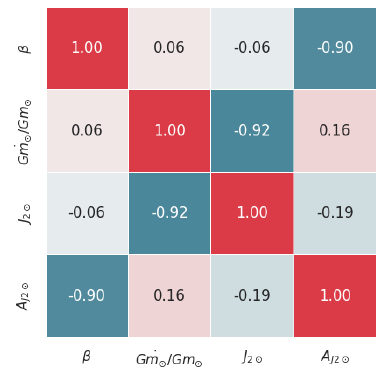
Figure 3. Correlation matrix between estimated parameters in the case that the amplitude A J estimated with a priori σ γ = 1.1 × 10 − 6 (corresponding to the Table 4). The correlation matrix is constructed using covariance matrix P (Equation